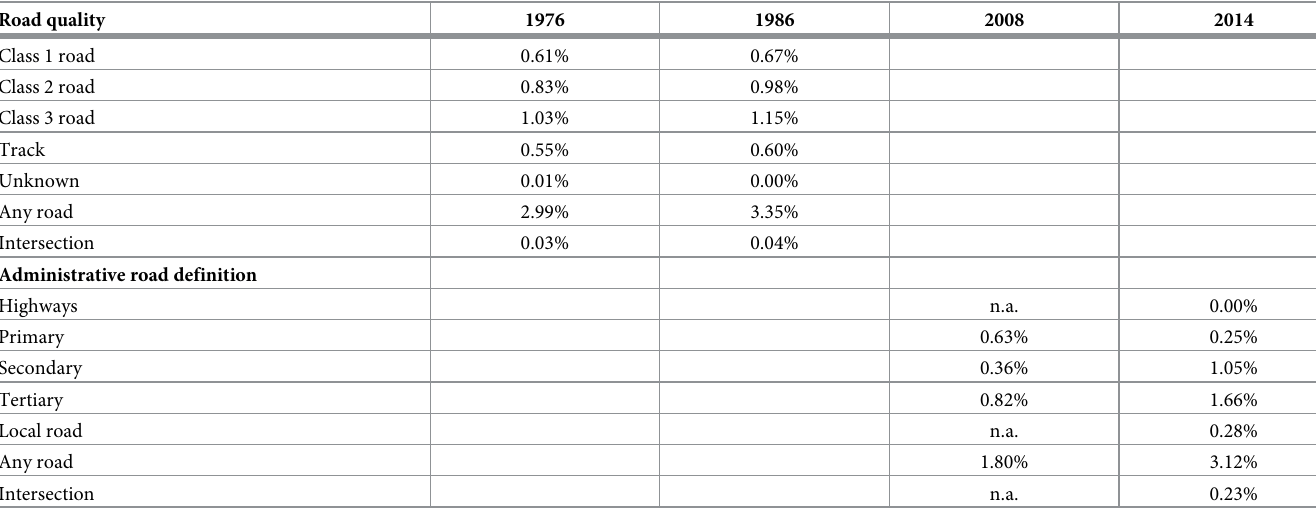
Table 2. Presence of roads in a